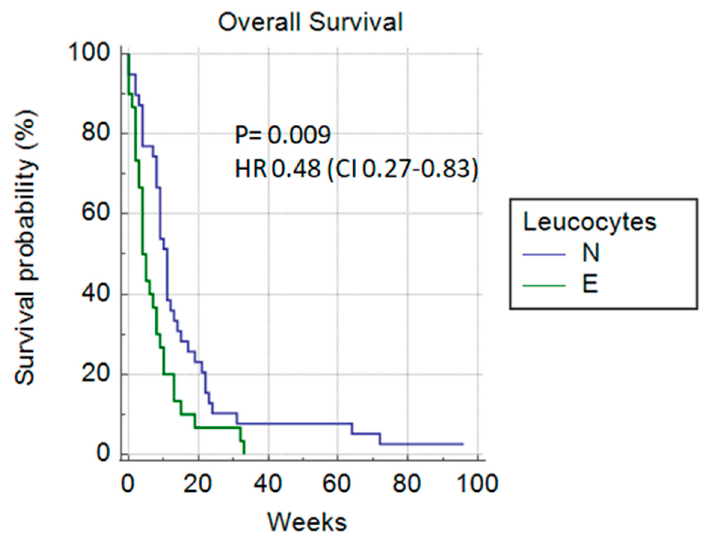
Figure 7. Leukocytes (normal vs. elevated).